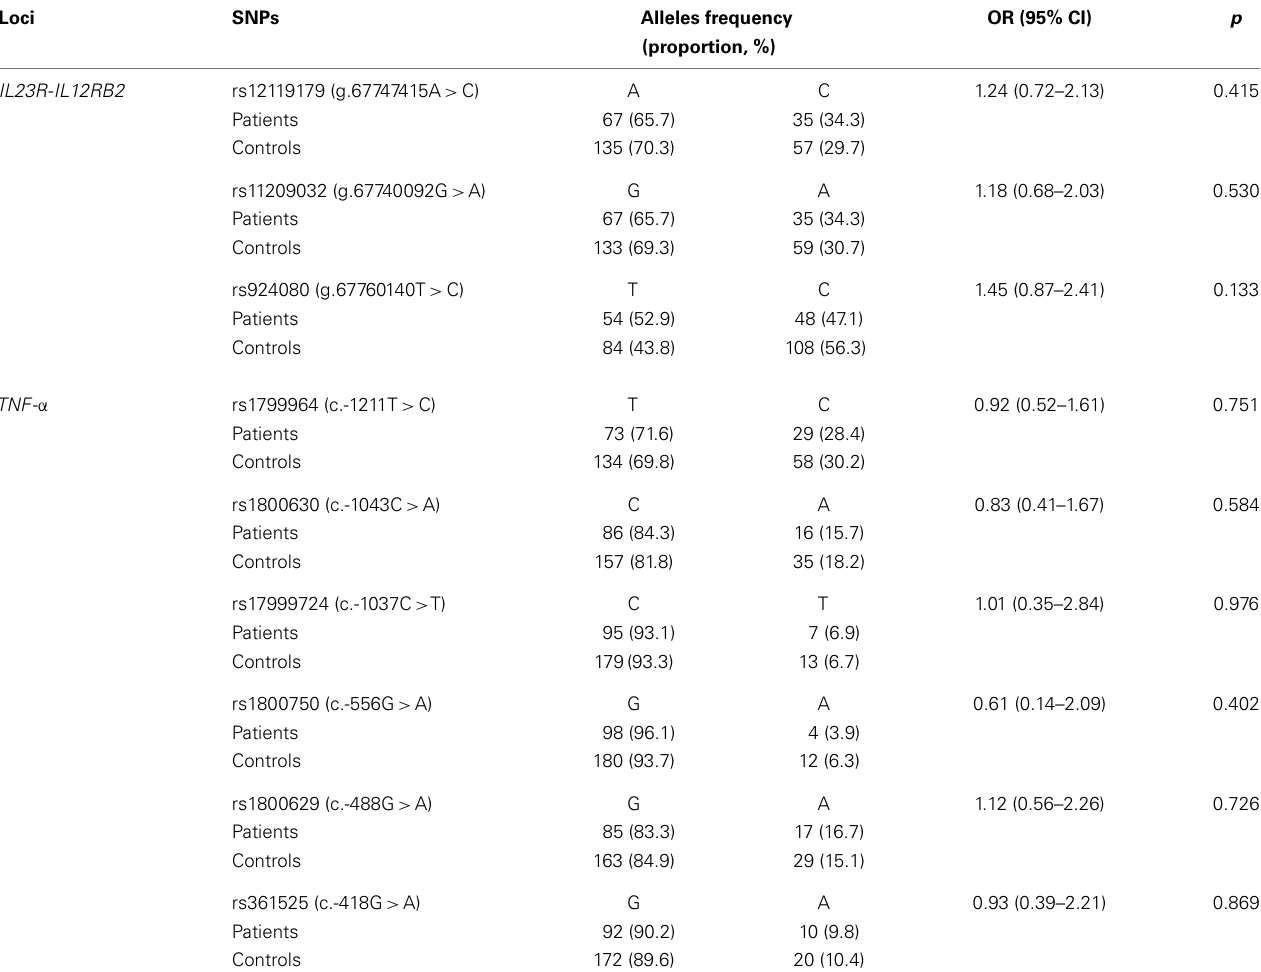
Table 5 | IL23R - IL12RB2 and TNF - α allelic frequencies in patients with Behçet’s disease.